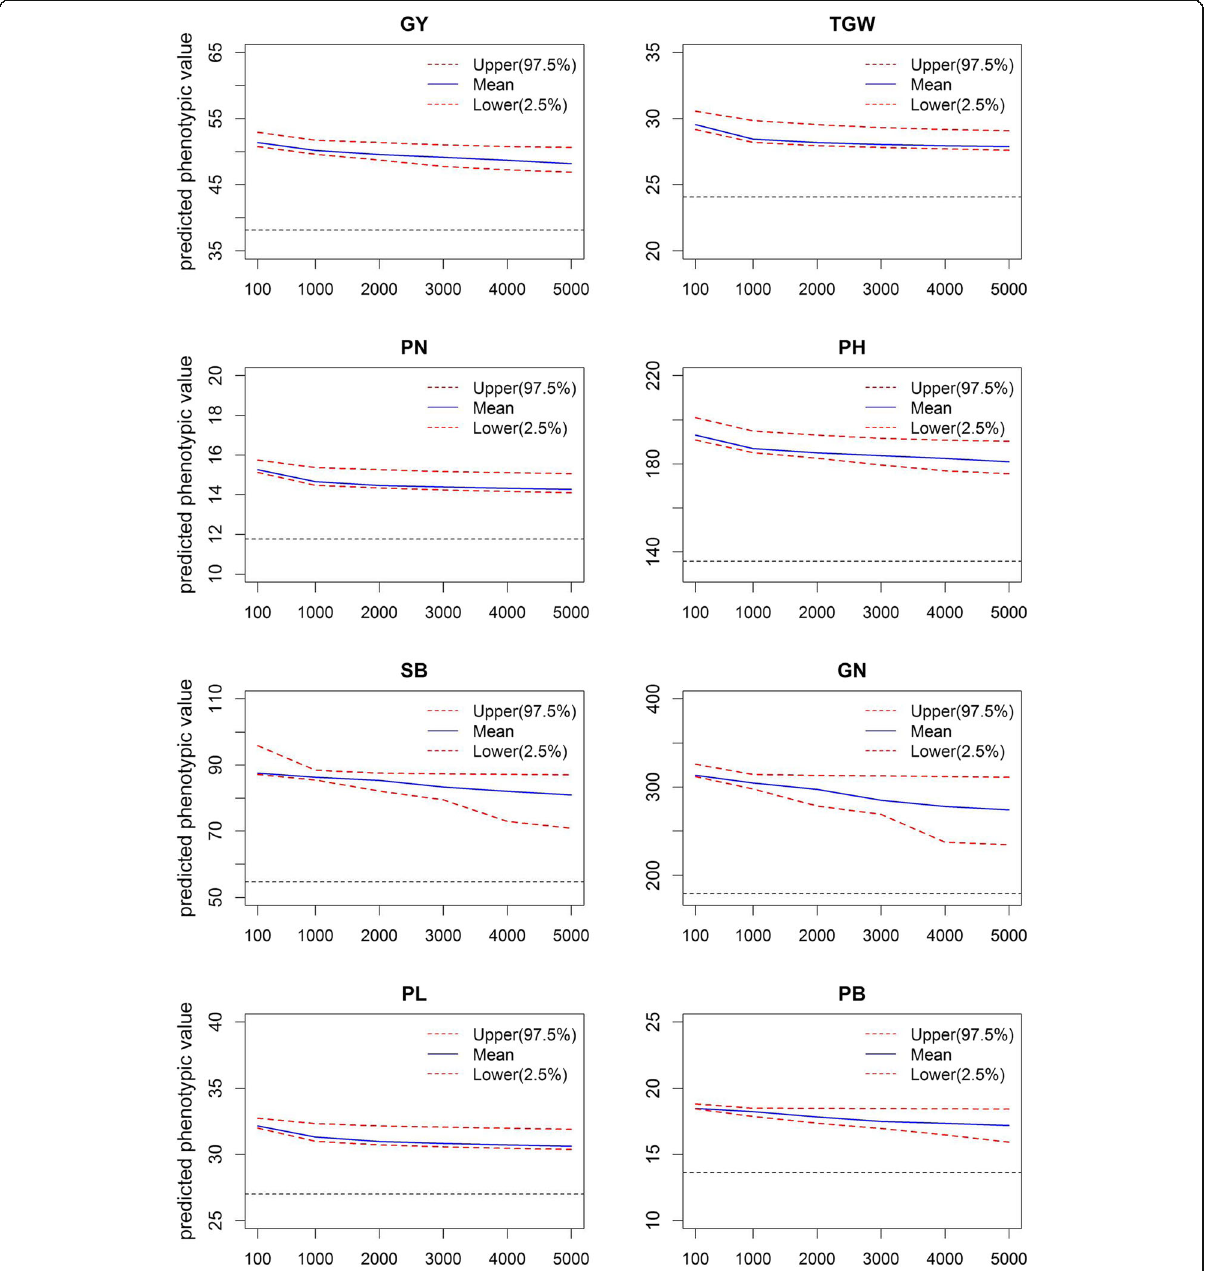
Fig. 5 Predicted phenotypic values of selected top crosses plotted against the number of crosses selected. The two red dotted curves define the 95% confidence intervals of the mean predicted phenotypic values. The black horizontal line in each panel denotes the average predicted phenotypic value of all crosses for that trait. The plot is truncated at 5000, and the total number of top crosses is